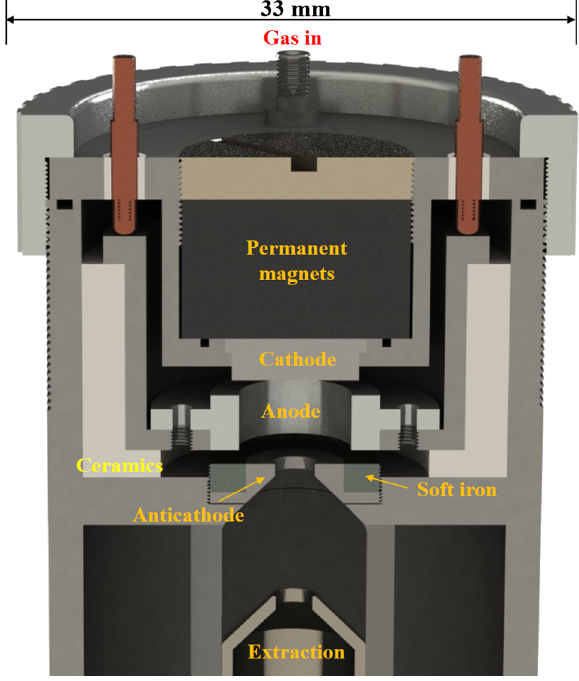
FIG. 2. Framework of the Penning